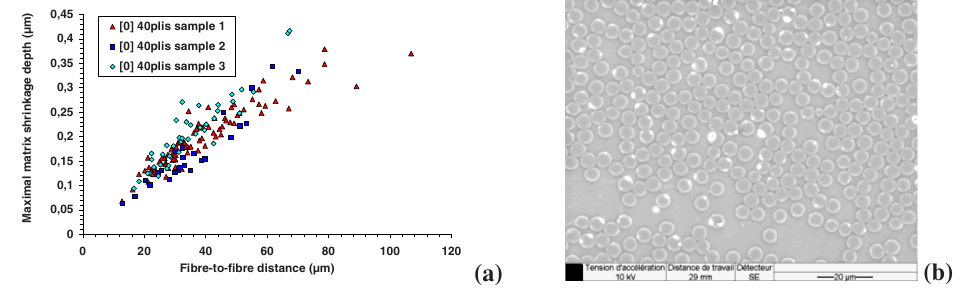
Fig. 3. CIM quantification of the maximal matrix shrinkage depth (a) and SEM observation of the sample polished surface (initial state, before aging)